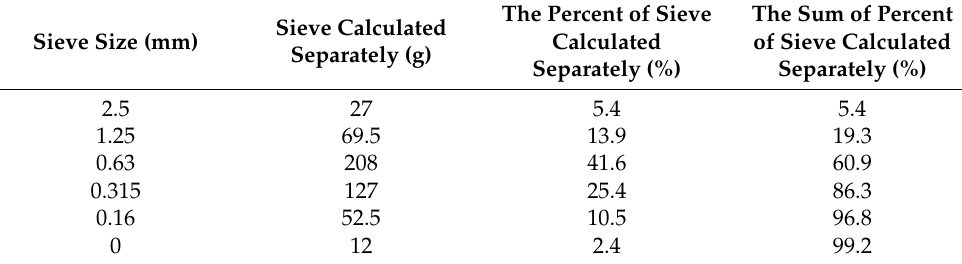
Table 1. Screening results of